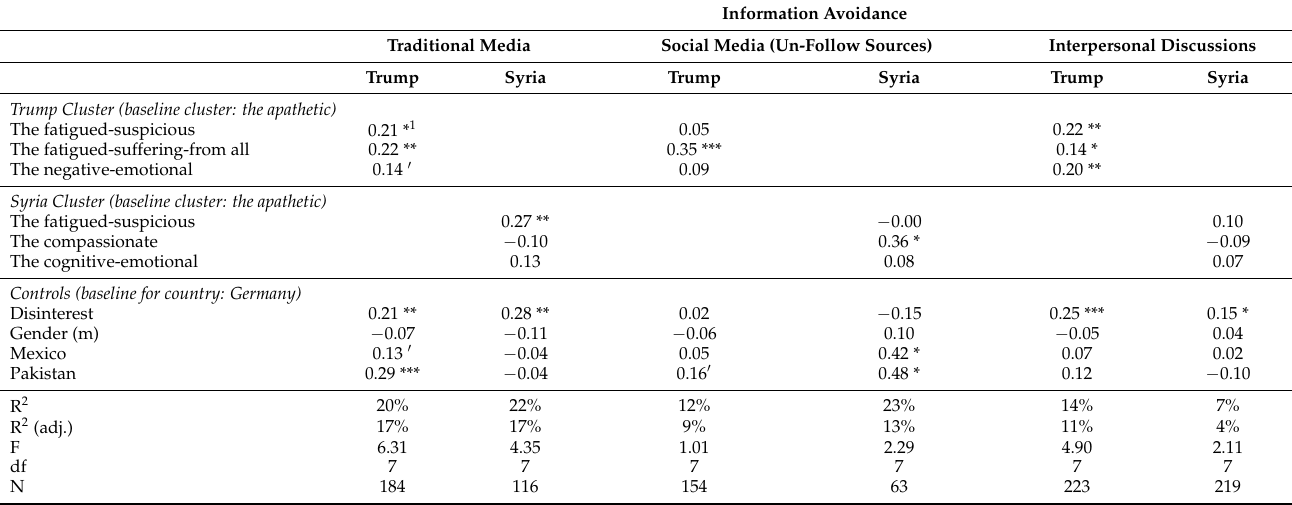
Table 4. Associations between issue fatigue clusters and information avoidance—multiple linear regression analysis with categorical variables and baseline